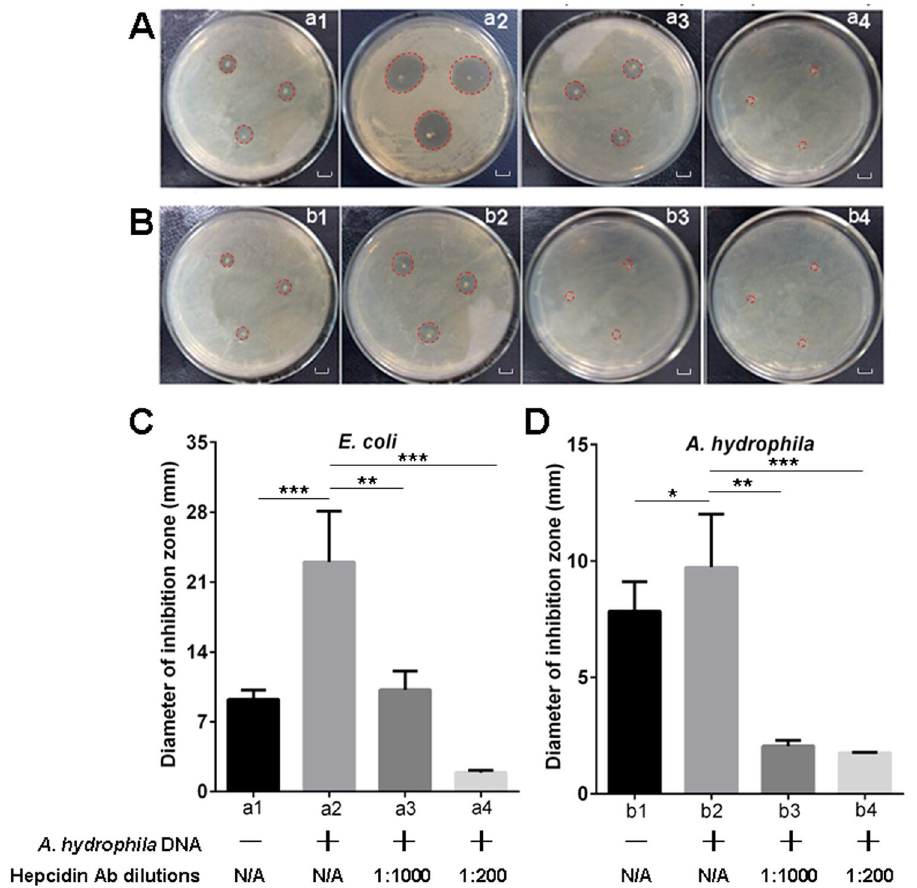
Figure 2. Evaluation of the bactericidal activity of hepcidin in various serum samples against test strains by inhibition zone assay. ( A and B ) Detection of the inhibition zones for E. coli ( A ) and A. hydrophila ( B ) strains by unstimulated serum (a1 and b1), A. hydrophila DNA (1 μ g per fish) stimulated serum (a2 and b2), A. hydrophila DNA stimulated serum neutralized with diluted (1:1,000) anti-hepcidin Ab (a3 and b3), and A. hydrophila DNA stimulated serum neutralized with diluted (1:200) anti-hepcidin Ab (a4 and b4), scale bars = 1 cm. ( C and D ) Measurement of the corresponding diameters of the inhibition zones (mm) from the inhibition zone assays by using serum samples with various treatments against E. coli ( C ) and A. hydrophila ( D ) strains. The labels a1 to a4 and b1 to b4 under the horizontal axis of C and D are in accordance with A and B . The annotations “ A . hydrophila DNA + / − ” and “Hepcidin Ab dilutions” under the labels represent that the E . coli (a1 to a4) and A . hydrophila (b1 to b4) were treated with the serum derived from A . hydrophila DNA stimulated ( + ) or unstimulated ( − ) fish, which were in combination with neutralizing the serum with anti-hepcidin Ab at different dilutions (1:1000 and 1:200) or without treatment with the anti-hepcidin Ab (N/A, not applicable). Data are representative of at least three independent experiments. * p < 0.05, ** p < 0.01, *** p <